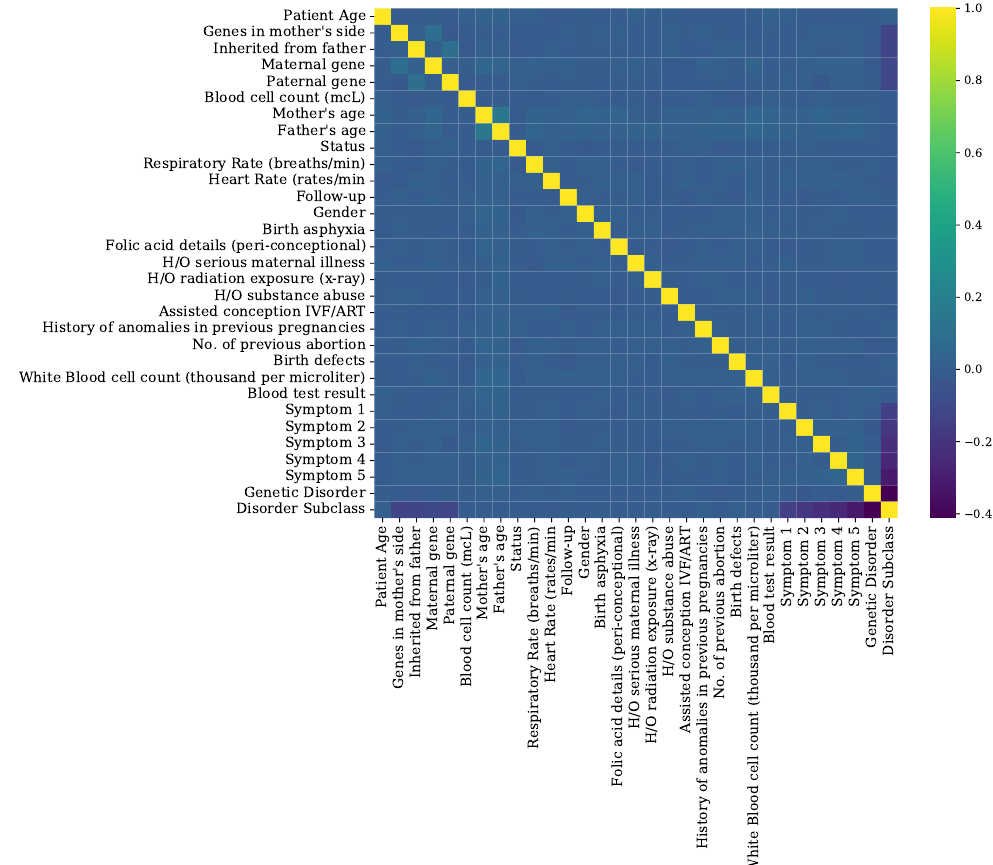
Figure 7. Feature correlation analysis graphs of genomes